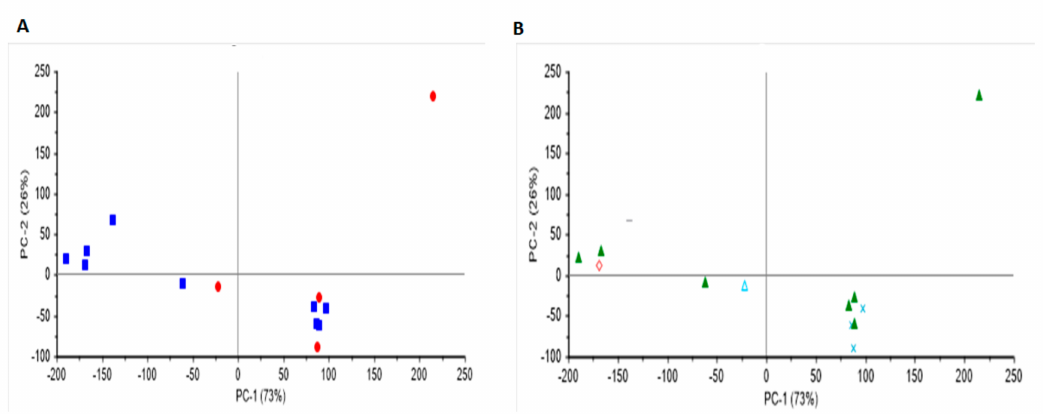
Figure 3. Principal component score plot of red wine samples analyzed using Raman spectroscopy. Panel A label by region ( Blue squares : Danuban plains; Red dots : Upper Thracian plains; Grey Triangles : ungroup samples) and Panel B label by variety ( Blue squares : Cabernet Franc; Red dots : Cabernet Sauvignon; Inverted triangle : Marselan; Cross : Melnik55; Pink line : Merlot; Green cross : Pinot Noir; Green square : Syrah).